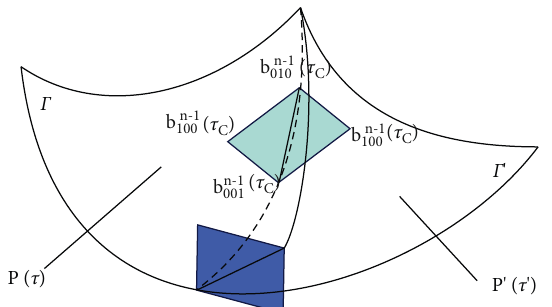
Figure 5: Continuity along boundary G 1